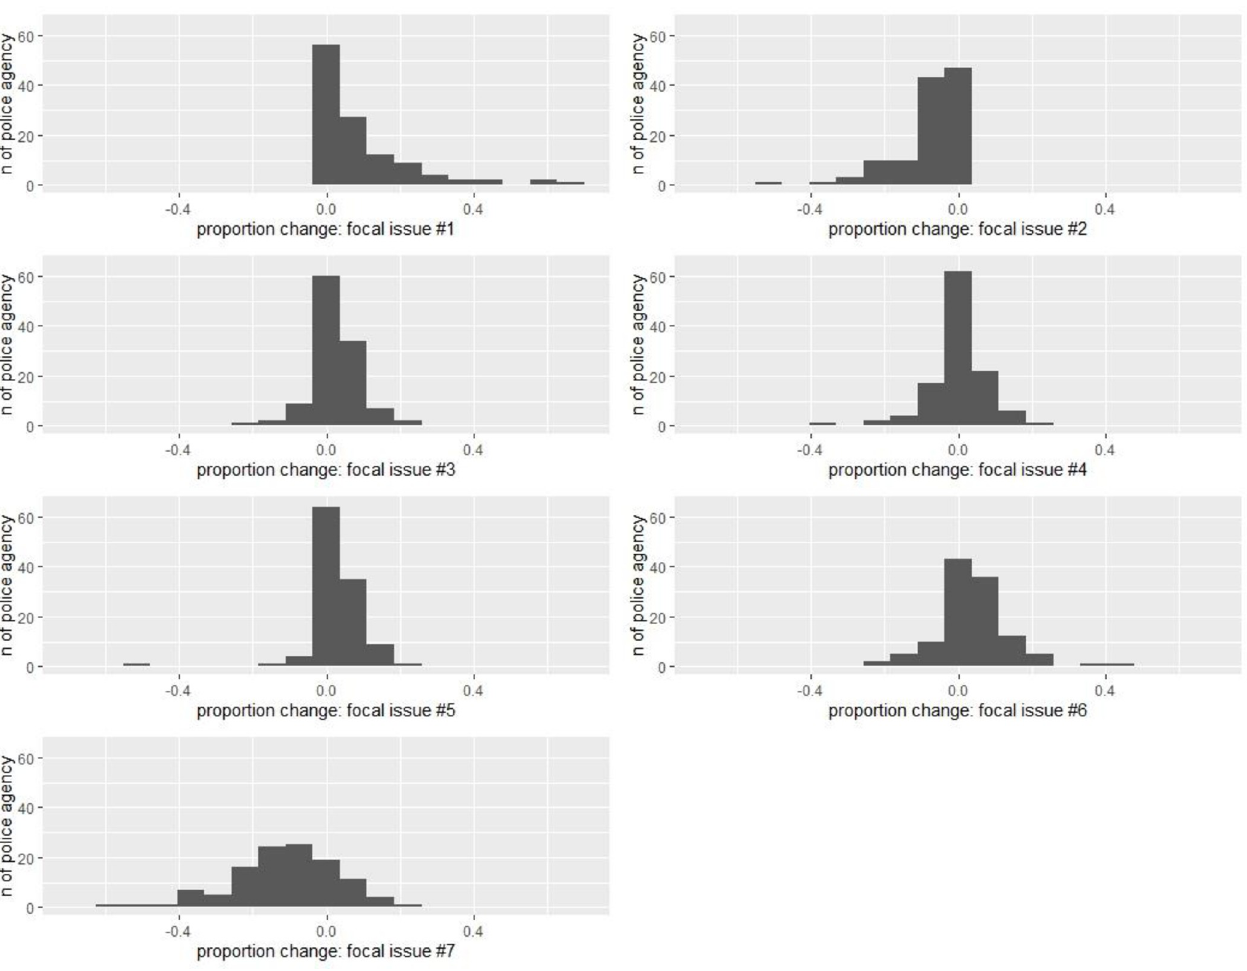
Fig 7. Distribution of police departments in relation to the changes in the focal issues of tweets posted by the 115 major police departments in the U.S. after the killing of George Floyd on May 25 th , 2020. Focal issues: (1) civil unrest related; (2) COVID-19 related; (3) police gathering of information; (4) police communication of administrative and mundane information; (5) police communication of traffic information; (6) police communication of case updates; and (7) community engagement and